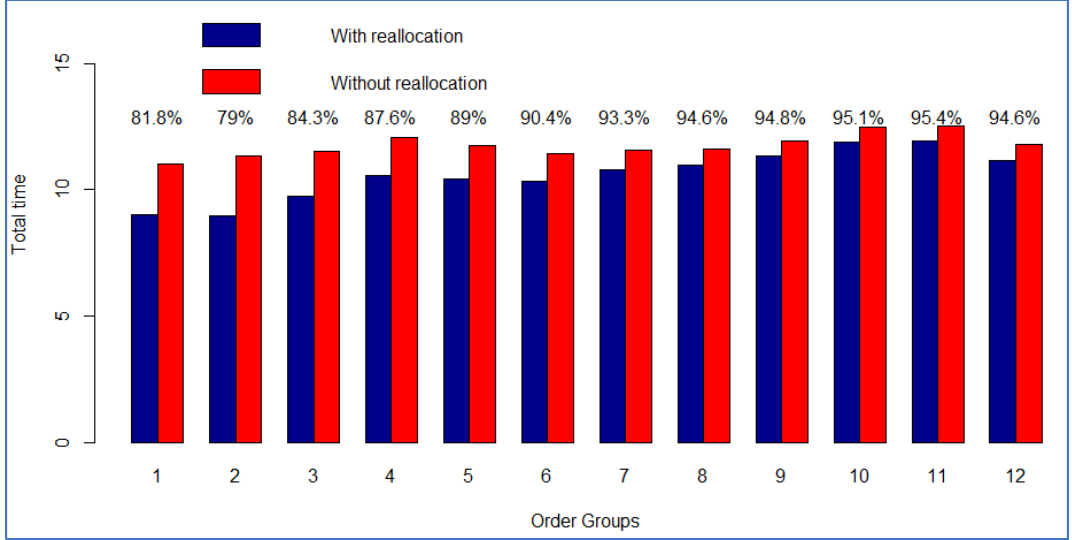
Figure 11. Savings in time for groups of 50 orders.